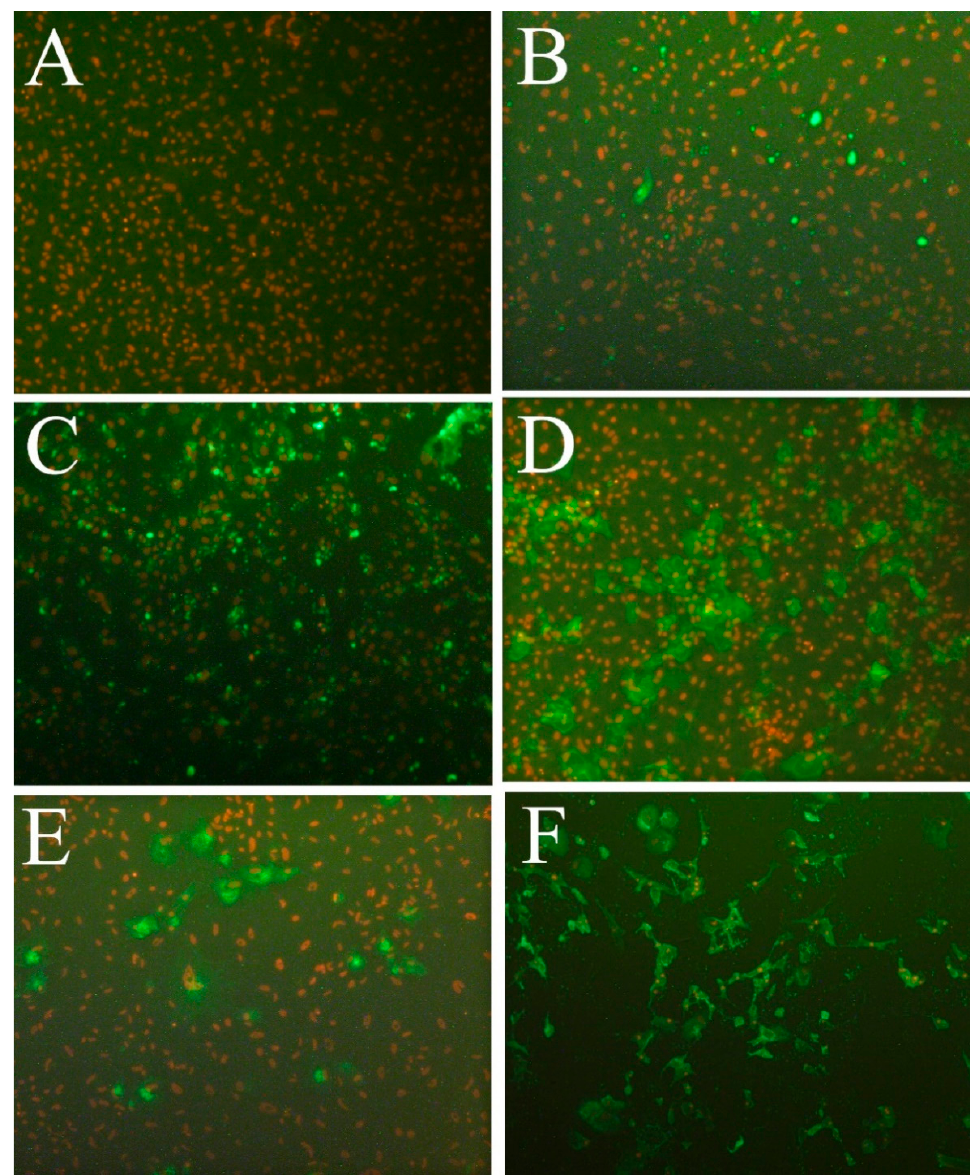
Figure 10. Susceptibility of LG-1 cells to fish viruses. LG-1 cells inoculated with ( A ) mock control, ( B ) ISAV, ( C ) betanodavirus (BFNNV genotype), ( D ) SAV1 ( E ) IHNV genogroup M and ( F ) VHSV genogroup III. Viral protein visualized by IFAT (green), cell nuclei by propidium Iodide (PI, red). Viral isolates and detection antibodies described in Table 2. Microscope: Leica DMIL.